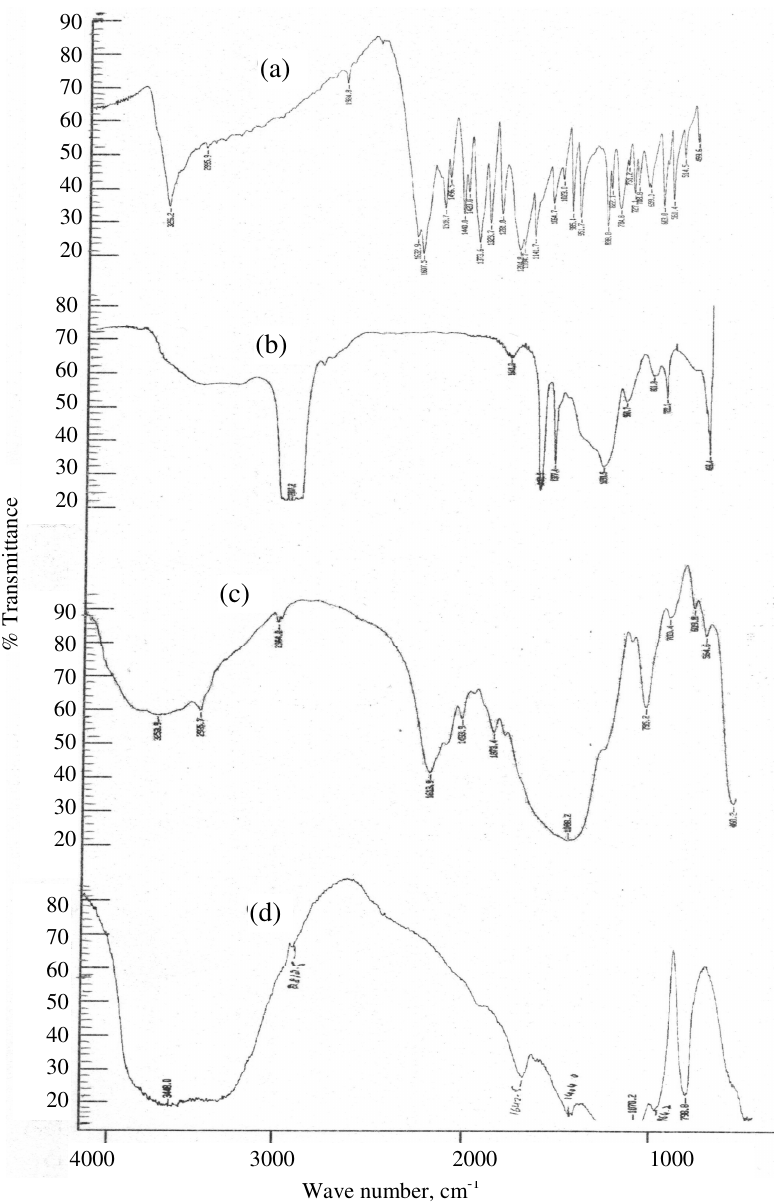
Figure 1. FTIR spectra (a) Resacetophenone (b) Nanometer SiO (c) Nanometer SiO – APTES (d) Nanometer SiO 2